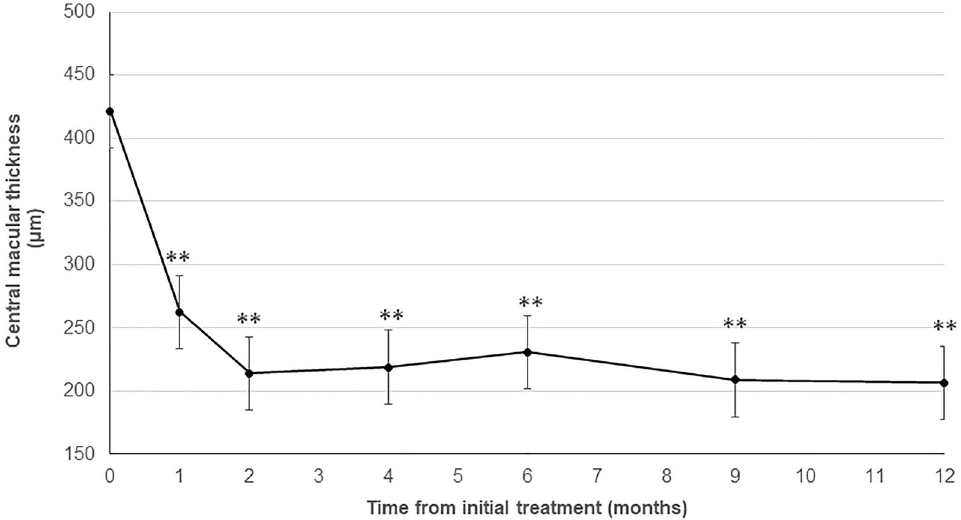
Figure 2. Changes in the central macular thickness (CMT) during the 12-month follow-up period. The mean CMTs at 4, 6, and 12 months decreased significantly compared with baseline (** P <